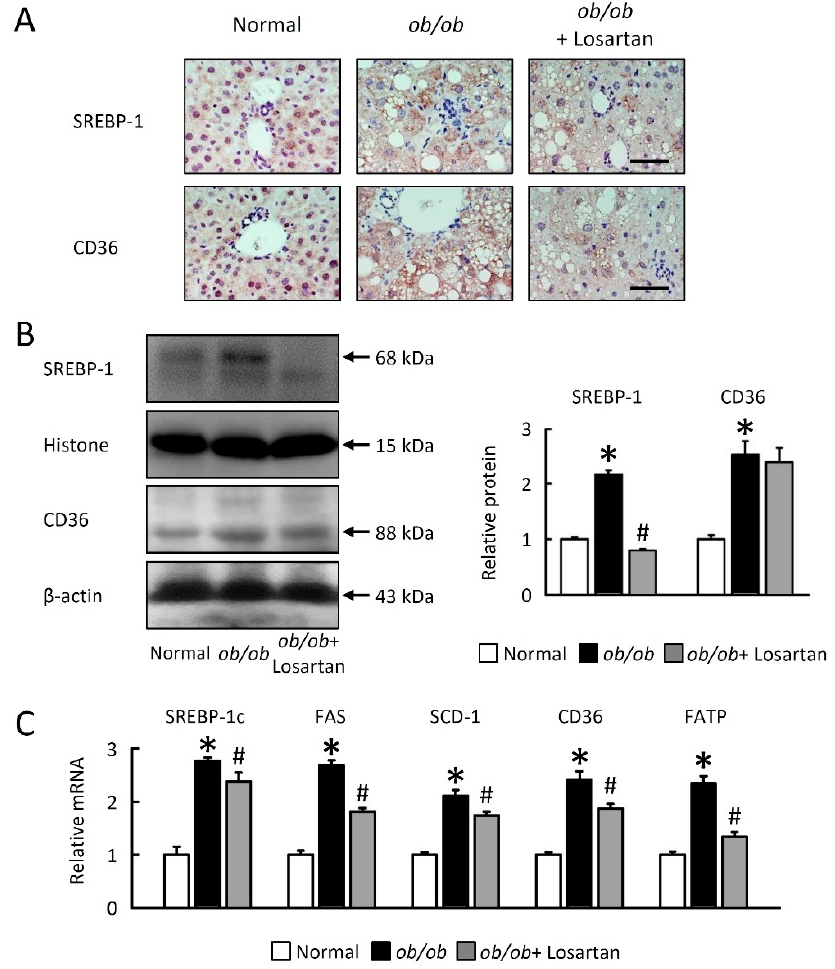
Figure 3. Losartan attenuates lipogenesis and improves lipolysis in liver. ( A ) Representative SREBP-1 and CD36 staining of liver from-treated ob/ob mice and normal mice. Scale bar: 100 μ m. ( B ) Quantification of SREBP-1 and CD36 protein levels by Western blot of liver after losartan treatment. Right-hand graphs indicate quantification relative to Histone (for SREBP-1) and β -actin (for CD36). ( C ) Quantification of SREBP-1c, FAS and SCD-1, CD36, and FATP by qRT-PCR. qRT-PCR indicate quantification relative to GAPDH. For each animal group, n = 5. All values represent the mean ± SEM. Data were analyzed by Student’s t test. * p ≤ 0.05; normal vs. ob/ob . # p ≤ 0.05; ob/ob vs. ob/ob + Losartan. SREBP-1, sterol regulatory element binding protein 1; CD36, cluster of differentiation 36; FAS, fatty acid synthase; SCD-1, stearoyl-CoA desaturase-1; FATP, fatty acid transport protein.